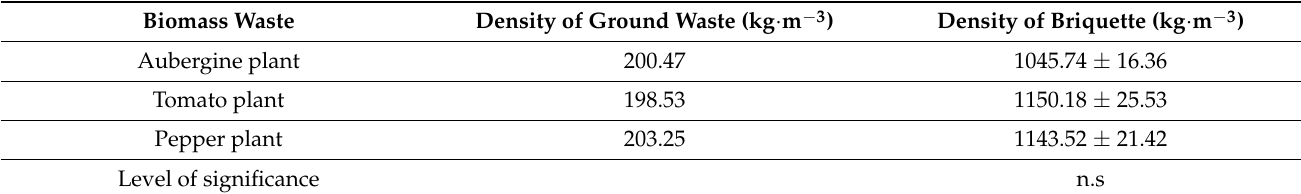
Table 3. Density (average values) and variance analysis results of briquettes.